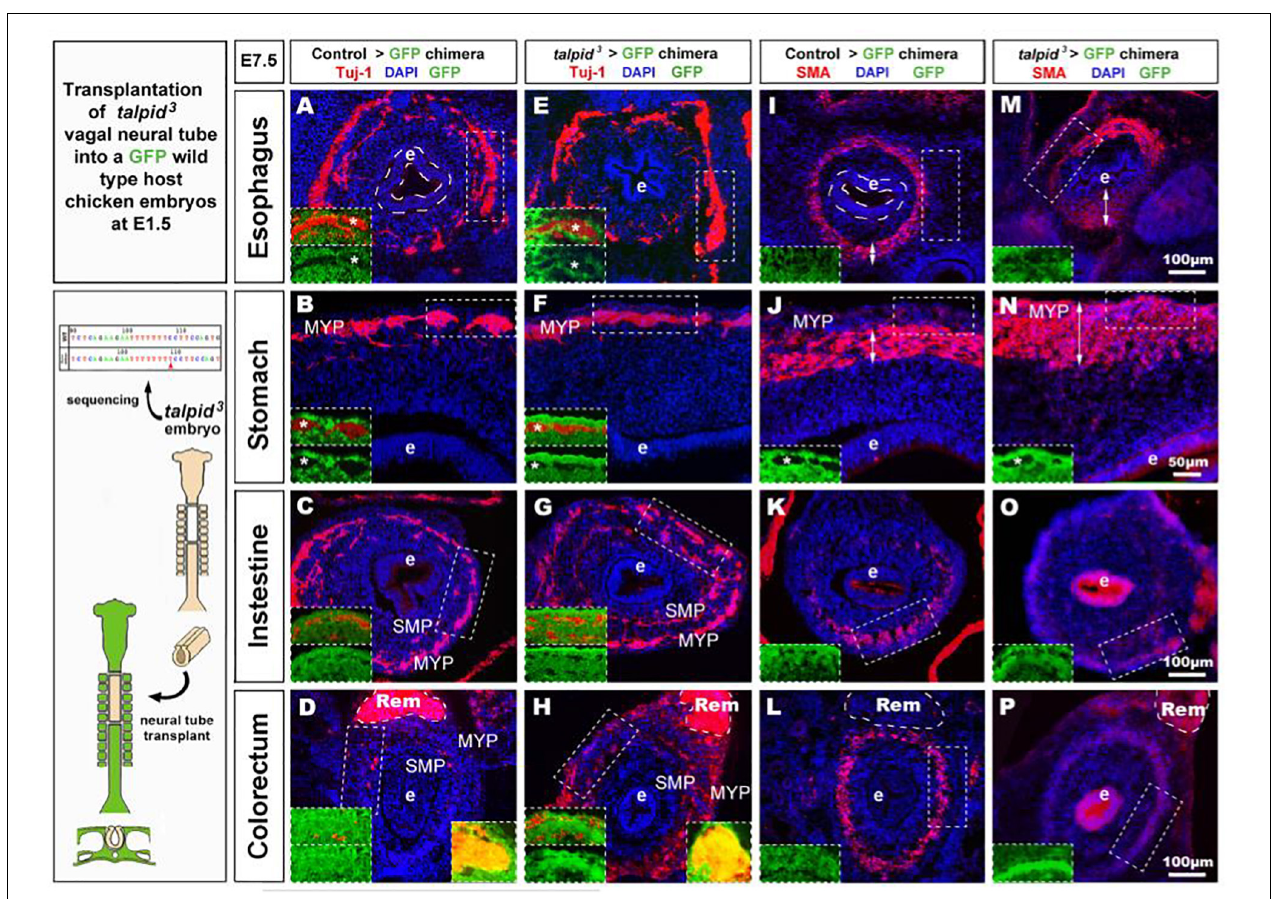
FIGURE 5 | talpid 3 > GFP chimeric embryos have grossly normal ENS but smooth muscle and epithelium defects. (A–P) E7.5 chimeric embryos after neural tube transplantation in (A–D,I,J) control > GFP and (B–H,M–P) talpid 3 > GFP. (A–P) Immunofluorescent staining for a TUJ-1+ and GFP [inset] in (A–H) and SMA and GFP [inset] in (I–P) . Panels (A–H) normal ENS patterning is observed in both control > GFP and talpid 3 > GFP. ( D,H insets) show the presence of (red) vagal TUJ-1+/GFP- ENCC (marked with asterisks *), as well as (yellow) TUJ-1+/GFP+ sacral ENCC in the Remak nerve. (E–H) TUJ-1 staining shows grossly normal ENS in talpid 3 > GFP chimera with a more mature/developed appearance of the ENS in the intestine and colon compared to the control chimera. (I–L) Well-defined circular SMA staining in control chimera. (M–P) Diffuse SMA expression and/or extended SMA domain (double headed arrows) in talpid 3 > GFP chimera. (O) SMA staining is almost absent in intestine of talpid 3 > GFP chimera. (P) Diffuse, yet circular SMA staining present in colorectum of talpid 3 > GFP chimera. (A,E,I,M) The endoderm of talpid 3 > GFP chimera is significantly thinner than controls at the level of the esophagus. e, endoderm; Rem, nerve of Remak; MYP, myenteric plexus; SMP, submucosal plexus. Same scale bar in (A–P)